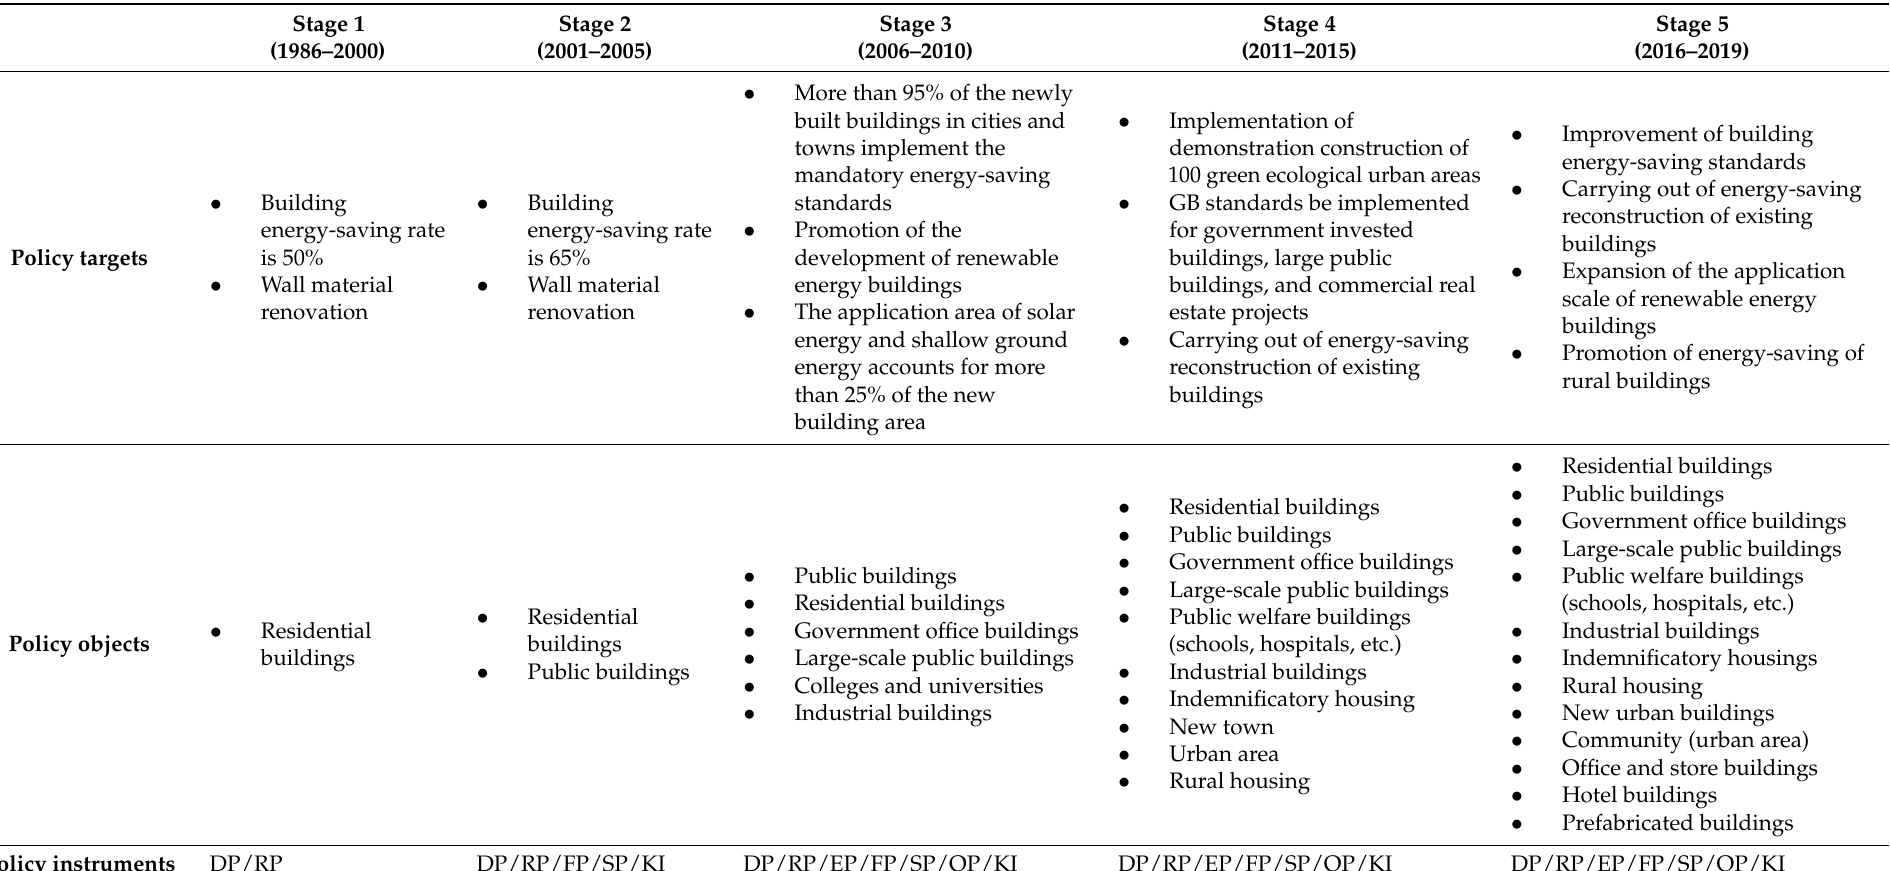
Table 2. Comparison of GBPs in different